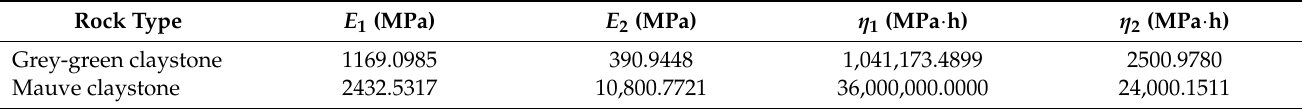
Table 4. The value of rheological parameters.